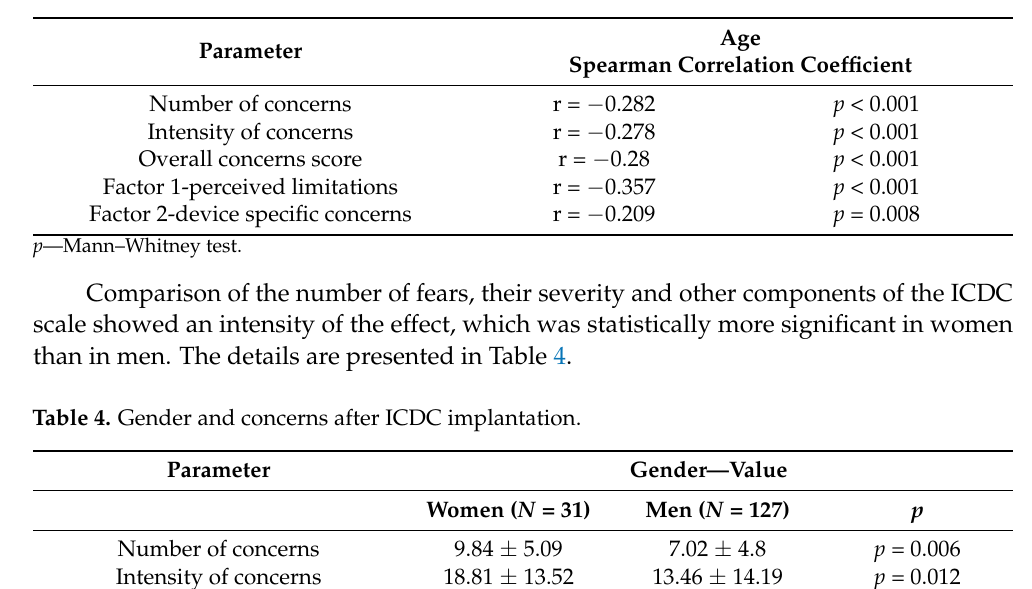
Table 3. Correlations between age and concerns on the ICDC scale. Parameter